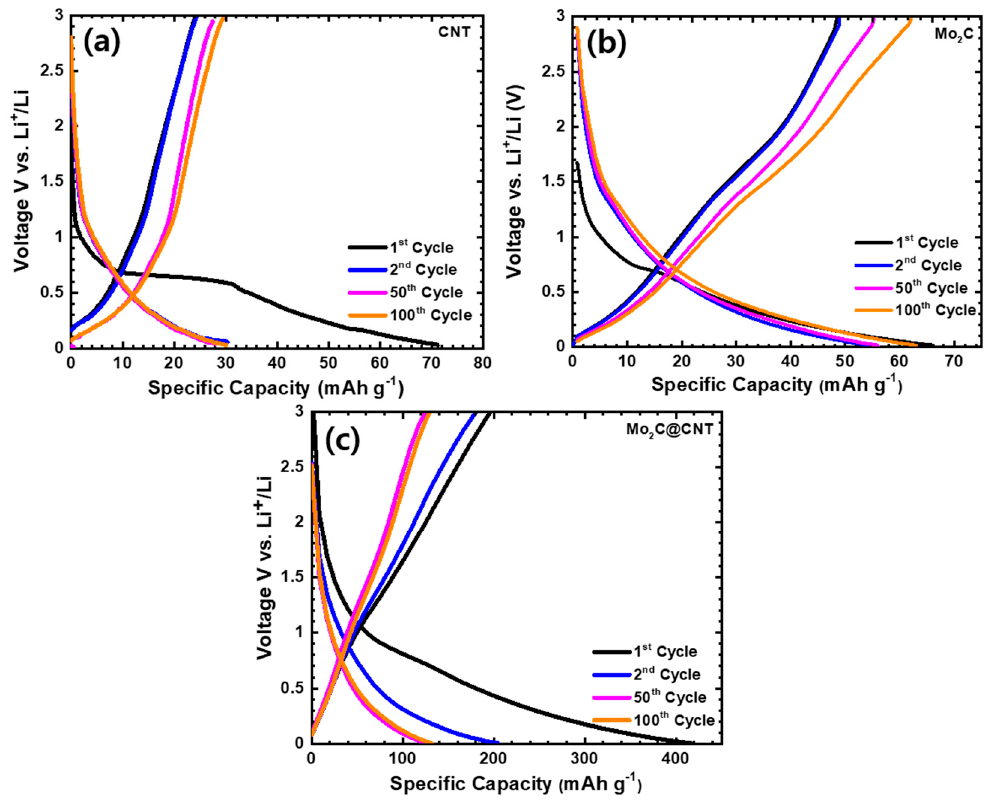
Figure 7. Charge-discharge at 50 mA g − 1 in the range of 0.01–3.0 V for ( a ) CNT, ( b ) Mo 2 C, and ( c ) Mo 2 C@CNT hybrid anodes at the 1st, 2nd, 50th, and 100th cycle for lithium-ion battery.